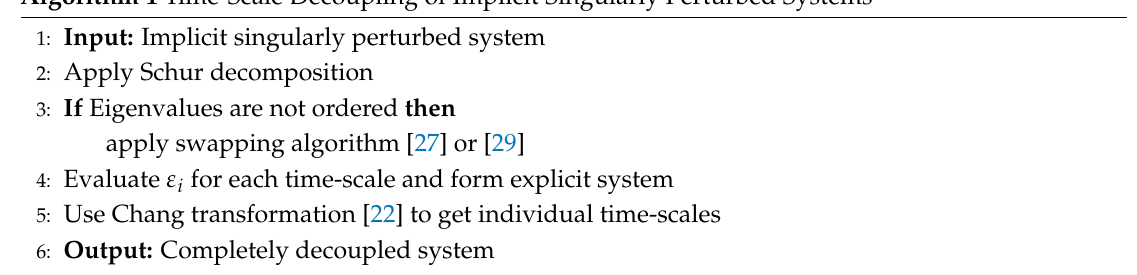
Algorithm 1 Time-Scale Decoupling of Implicit Singularly Perturbed